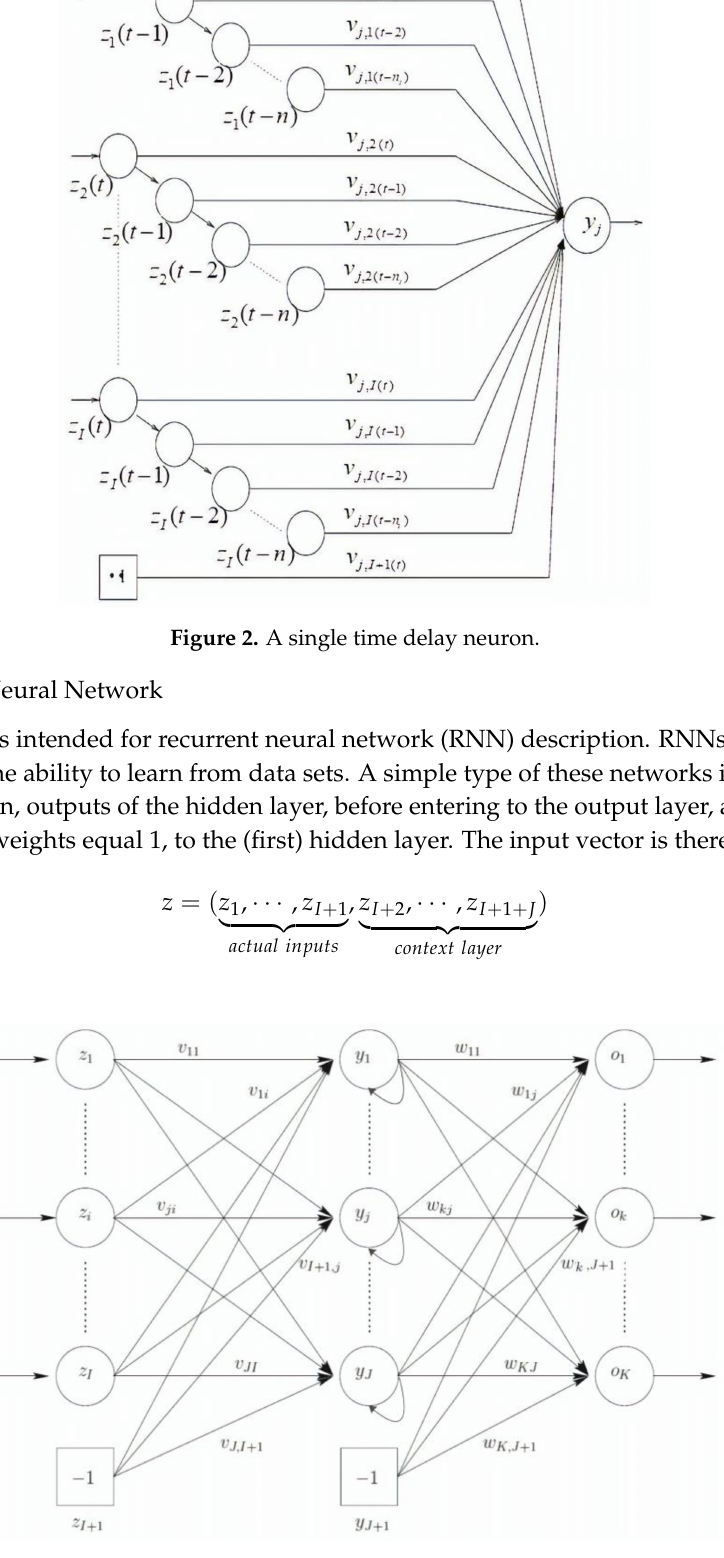
Figure 3. A recurrent neural network